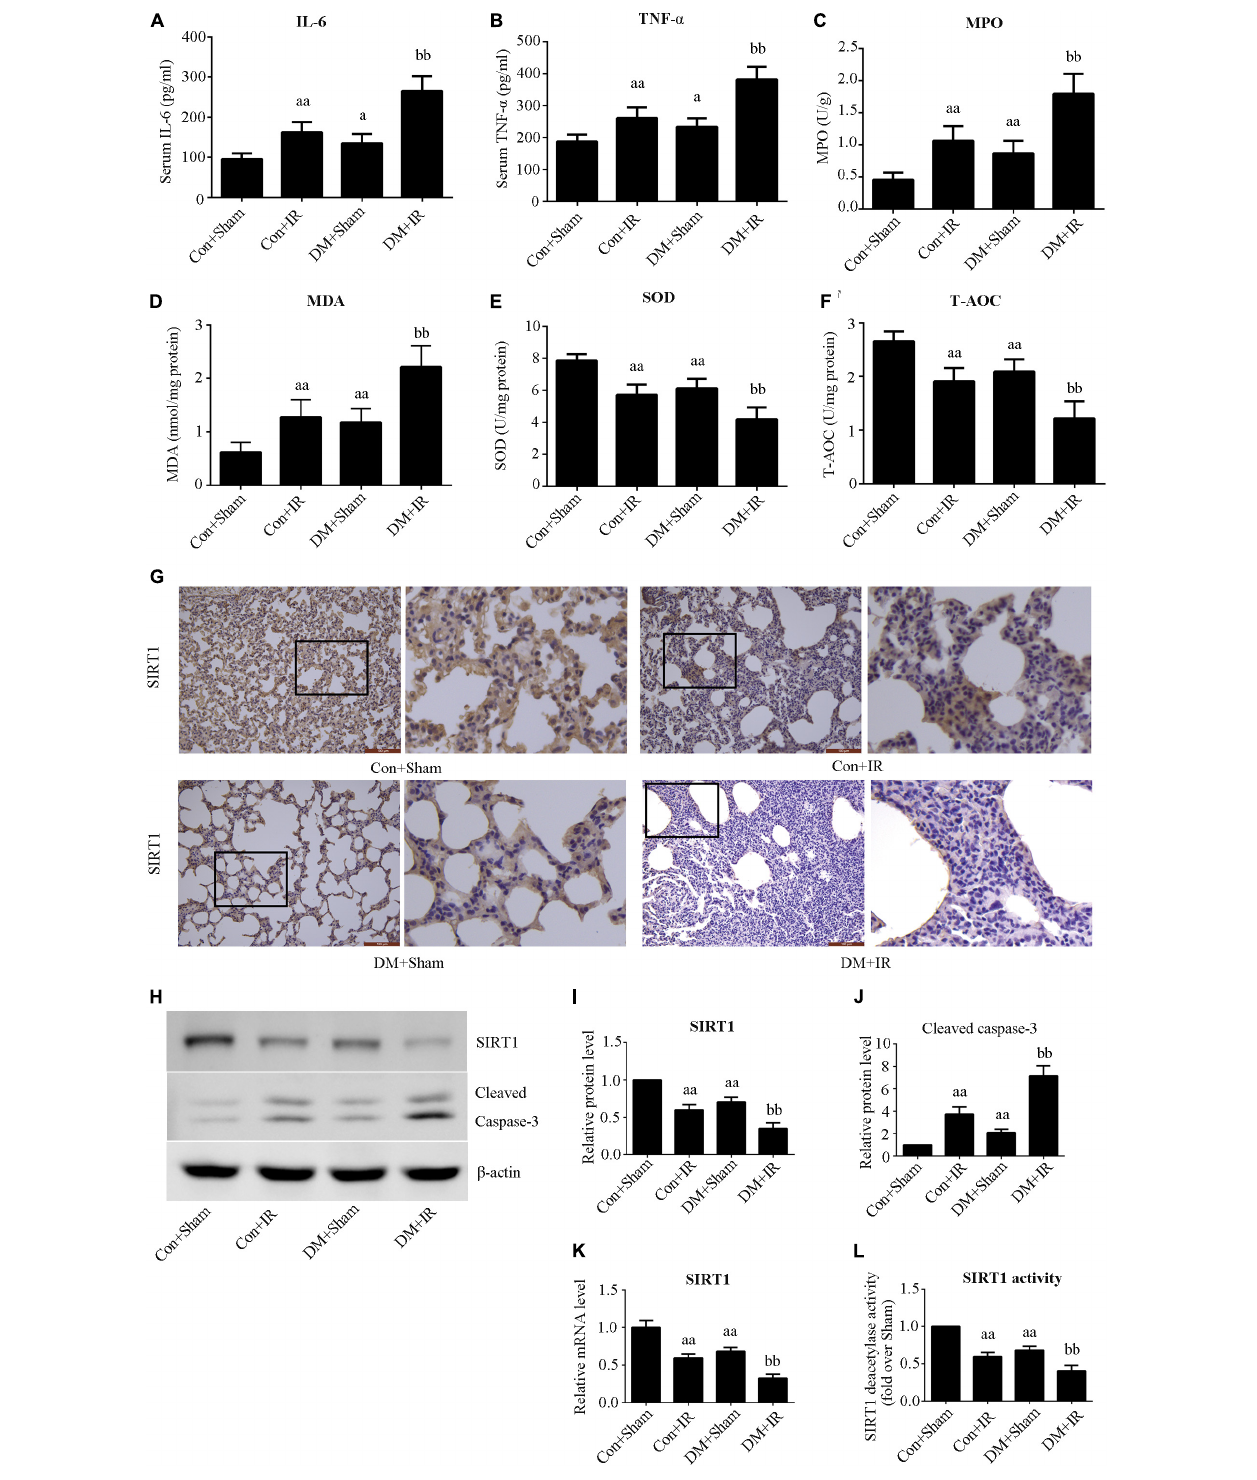
FIGURE 2 | Type 2 DM impaired lung SIRT1 signaling and enhanced oxidative stress, inflammation, and apoptosis. (A) SOD concentration. (B) T-AOC concentration. (C) MDA concentration. (D) MPO concentration. (E) Serum concentrations of interleukin-6 (IL-6). (F) TNF- α . (G) Representative lung immunohistochemical images of SIRT1 (magnification: 200 × ). (H) Representative blots. (I) SIRT1 expression. (J) Cleaved caspase-3 expression. (K) mRNA expression of SIRT1 ( n = 4). (L) Relative SIRT1 activity. IL, interleukin; TNF-a, tumor necrosis factor-a; MPO, myeloperoxidase; MDA, malonaldehyde; SOD, superoxide dismutase; T-AOC, total antioxidative capability ( a P < 0.05 versus Con + sham group/ aa P < 0.01 versus Con + sham group, bb P < 0.01 versus Con + IR group; n = 8 in each group).